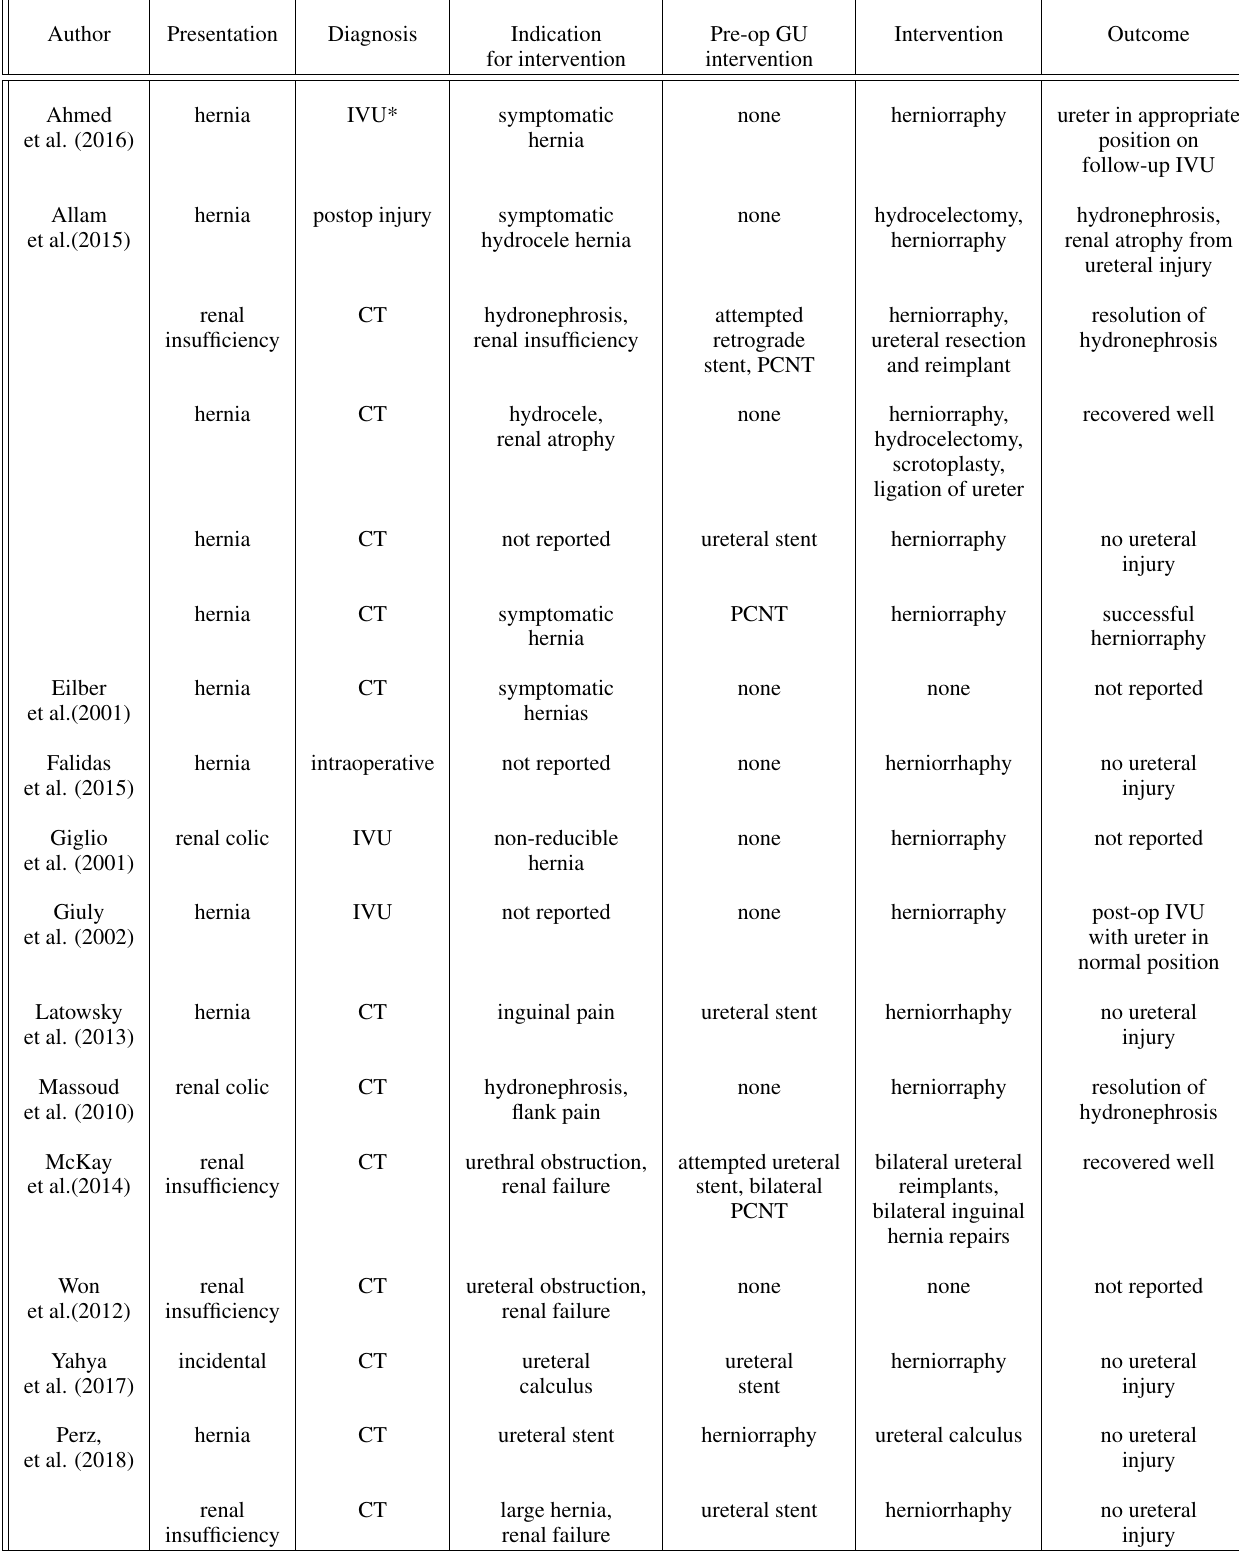
Table 1. Analysis of studies meeting criteria for inclusion (1-11). *IVU: intravenous